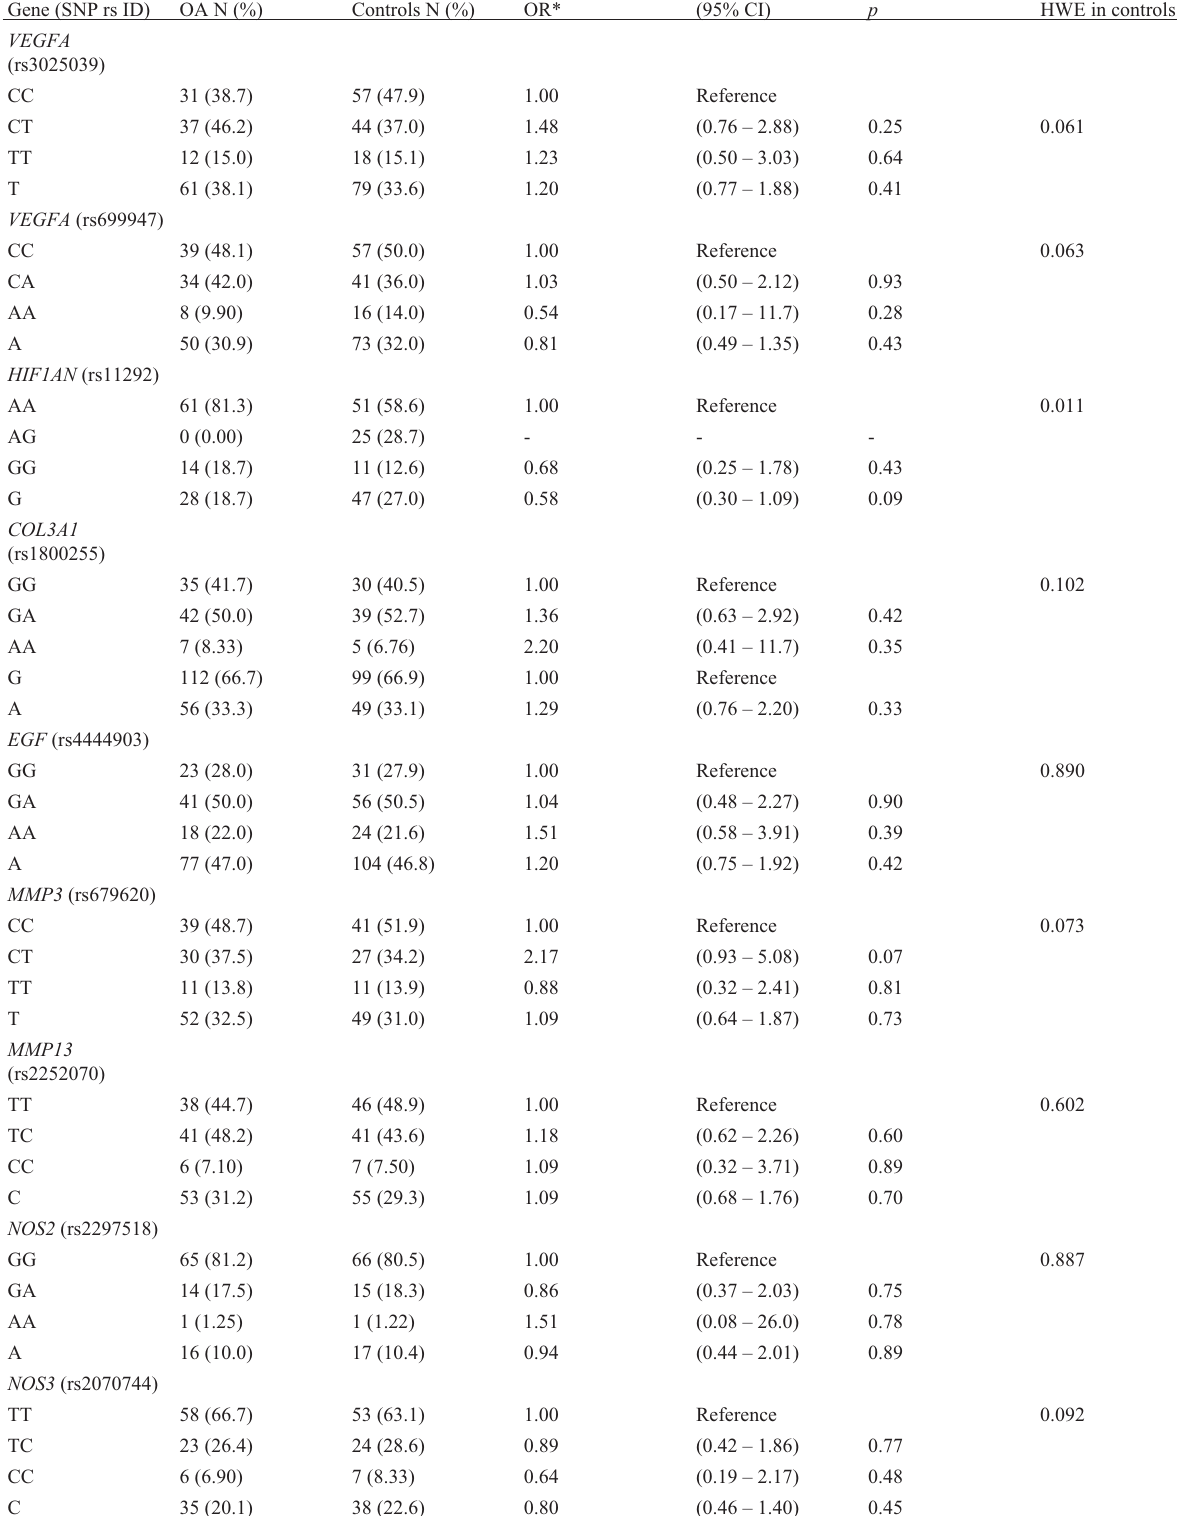
Table 3 - Genetic and allelic frequencies of SNPs studied in OA patients and